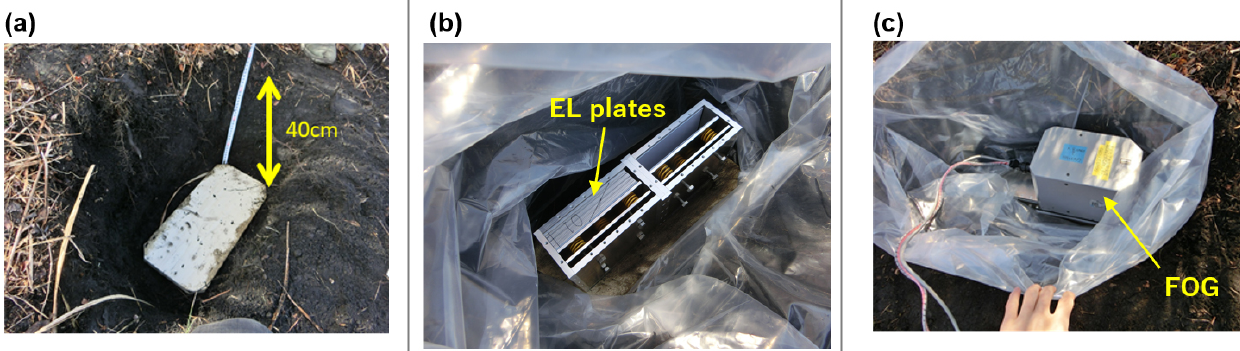
Figure 5. Photographs showing the installation procedure. (a) Dig a hole and place a plywood sheet in the bottom. (b) Place the outer box in the hole and put a stack of EL plates into the box. The plates were aligned over a period of < 30s. After closing the top plate of the box, the feed screws were tightened to increase the pressure. (c) The yaw, roll, and pitch were measured with a fiber optic gyro (FOG) and digital leveler.